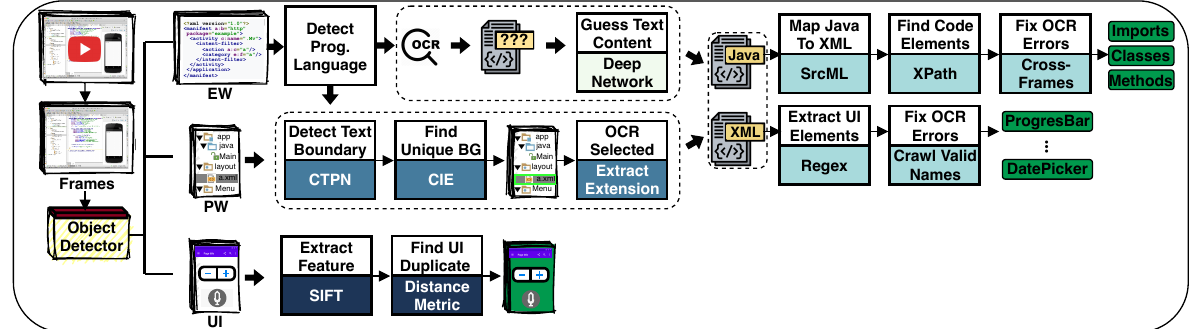
Figure 1. An overview of VID2META for extracting code elements and GUIs from Android